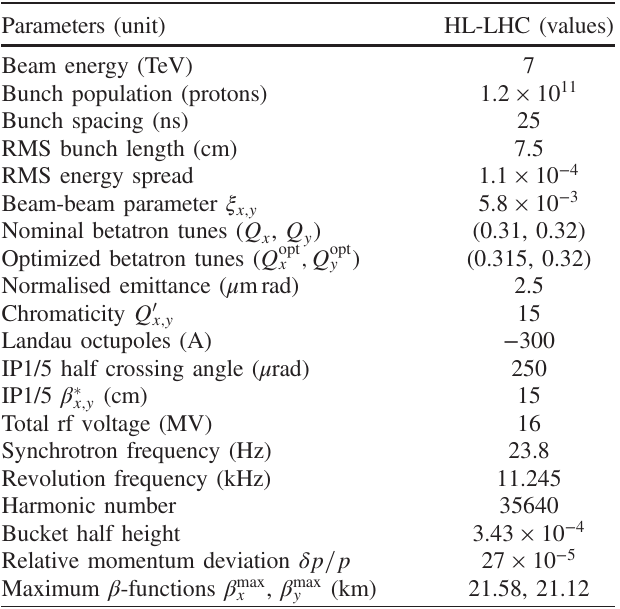
TABLE II. The simulation parameters of the HL-LHC lattice at the end of the luminosity levelling during collisions based on the nominal operational scenario